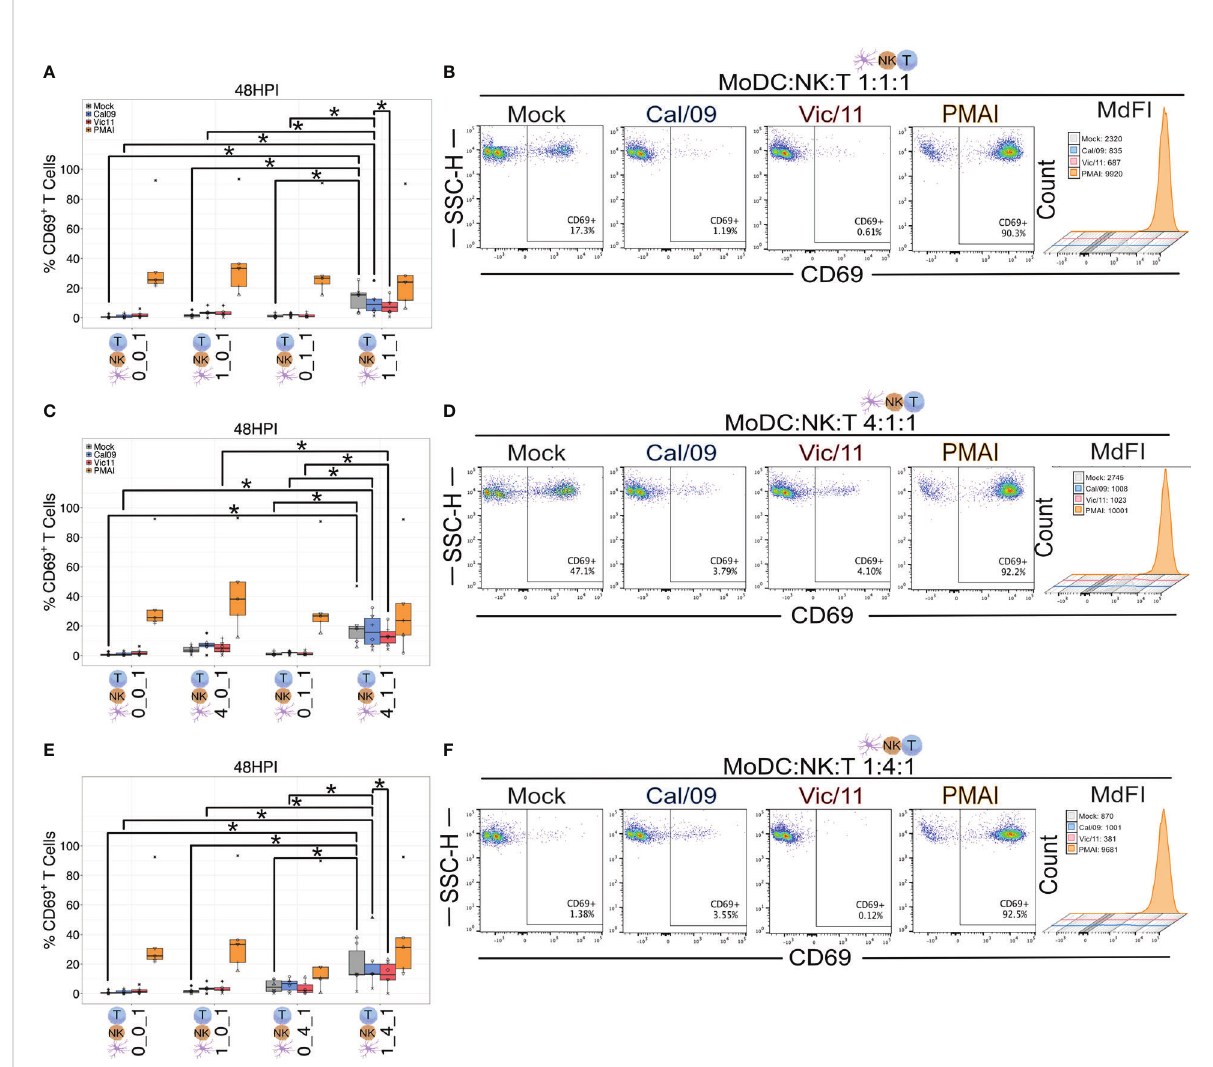
FIGURE 5 MoDC-NK cell cross-talk increases the frequency of an early marker of T cell activation. Summary plots of the frequency of CD69 + T cells after culture with mock-treated or Cal/09 or Vic/11-exposed MoDCs (MOI = 3) after 95 h co-culture with MoDCs and NK cells ( n = 6) at a MoDC to NK cell to T cell ratio of (A) 1:1:1, (C) 4:1:1, and (E) 1:4:1 as assessed by fl ow cytometry using an antibody speci fi c to CD69. Representative fl ow plots of the frequency of CD69 + T cells expression and MdFI after 47 h co-culture with Cal/09- or Vic/11-exposed MoDCs (MOI = 3) at a MoDC to NK cell to T cell ratio of (B) 1:1:1, (D) 4:1:1, and (F) 1:4:1. PMA/I treatment for 12 h served as a positive control. The same shape between conditions indicates that the data point is derived from the same donor. * p < 0.05, Wilcoxon signed-rank